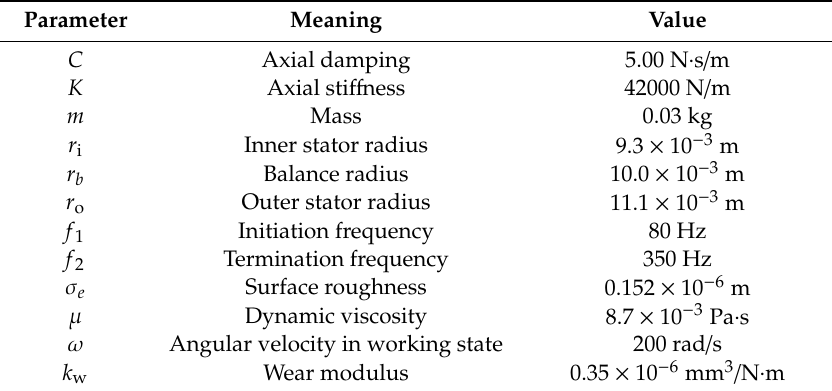
Table 2. Main parameter values.